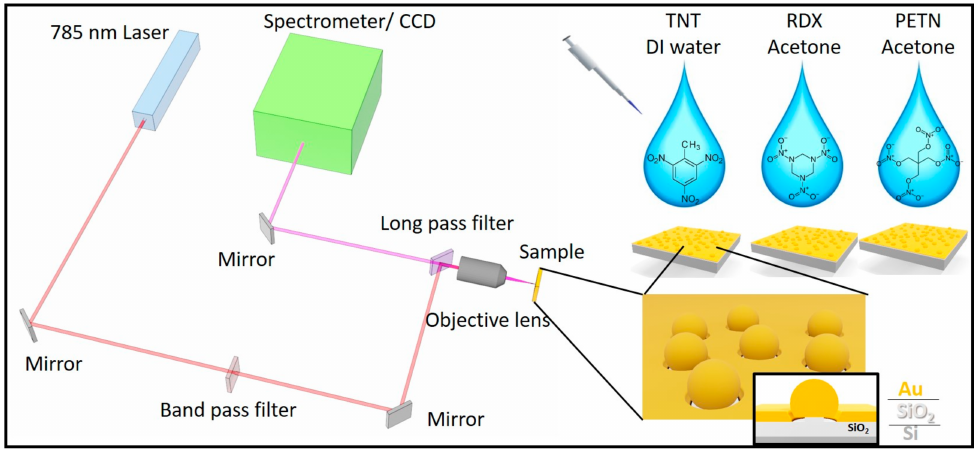
Figure 1. Schematic diagram of an experimental